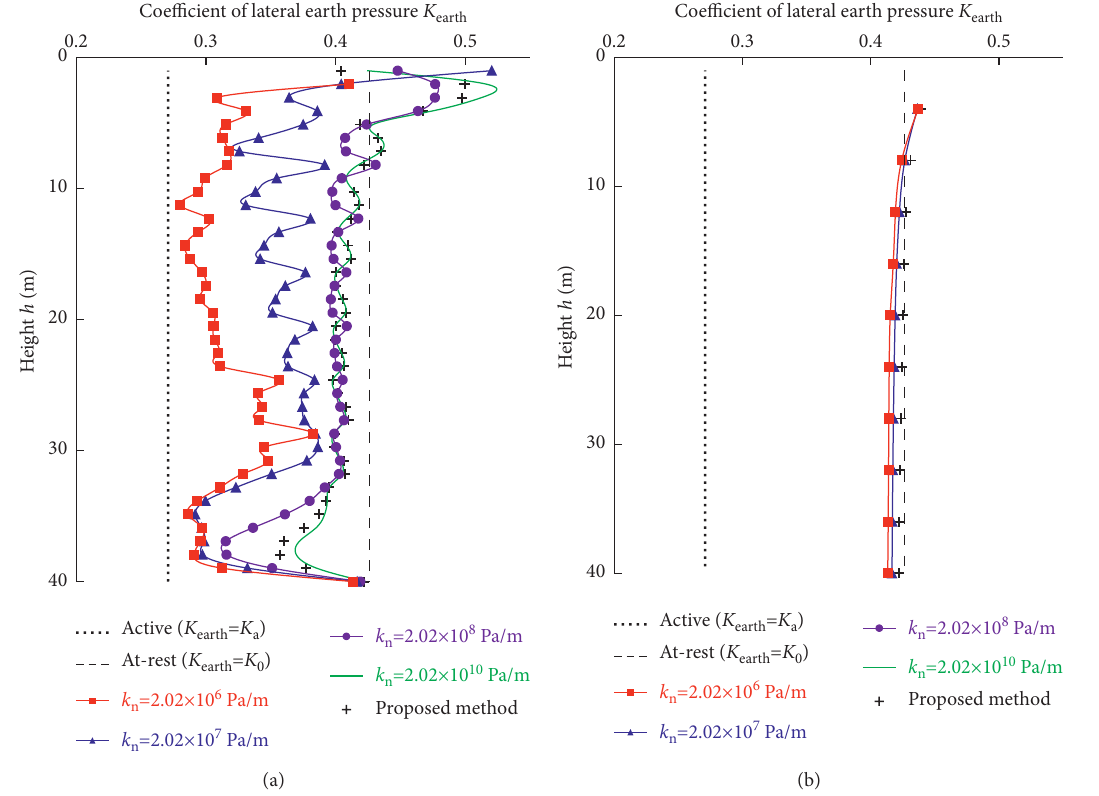
Figure 11: Coefficient of lateral earth pressure calculated by stresses (a) plotted along VCL and (b) monitored at MPSB with different normal stiffness (k) n of